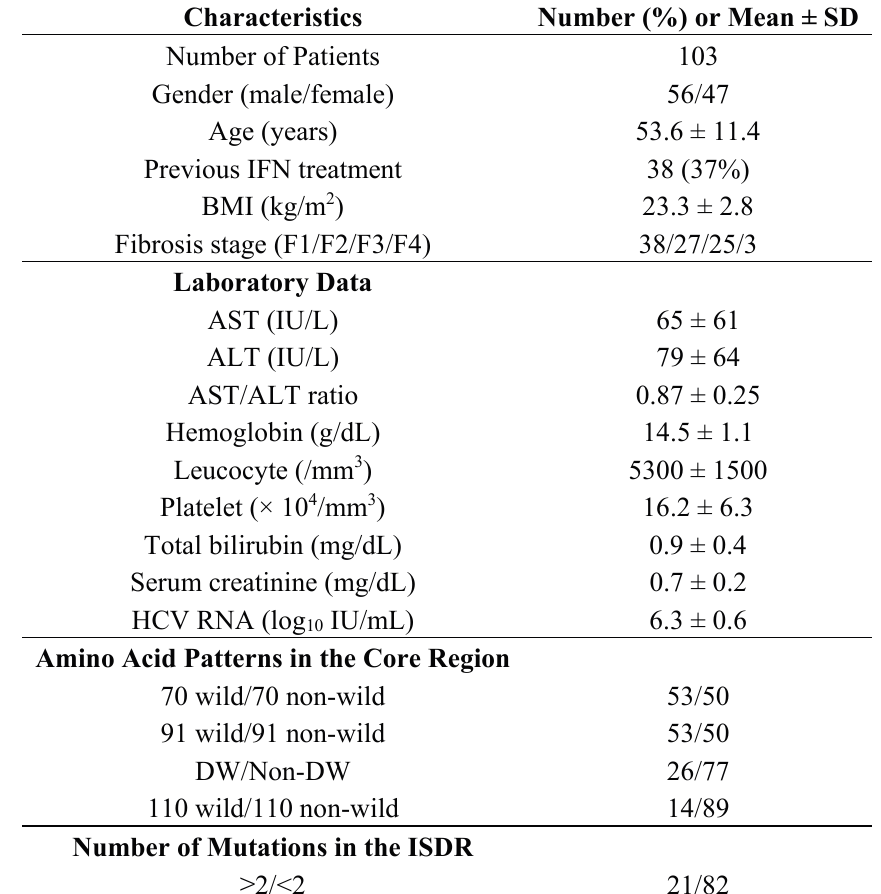
Table 4. Clinicopathological features of patients infected with hepatitis C virus (HCV) genotype 1b at the start of peginterferon plus ribavirin combination